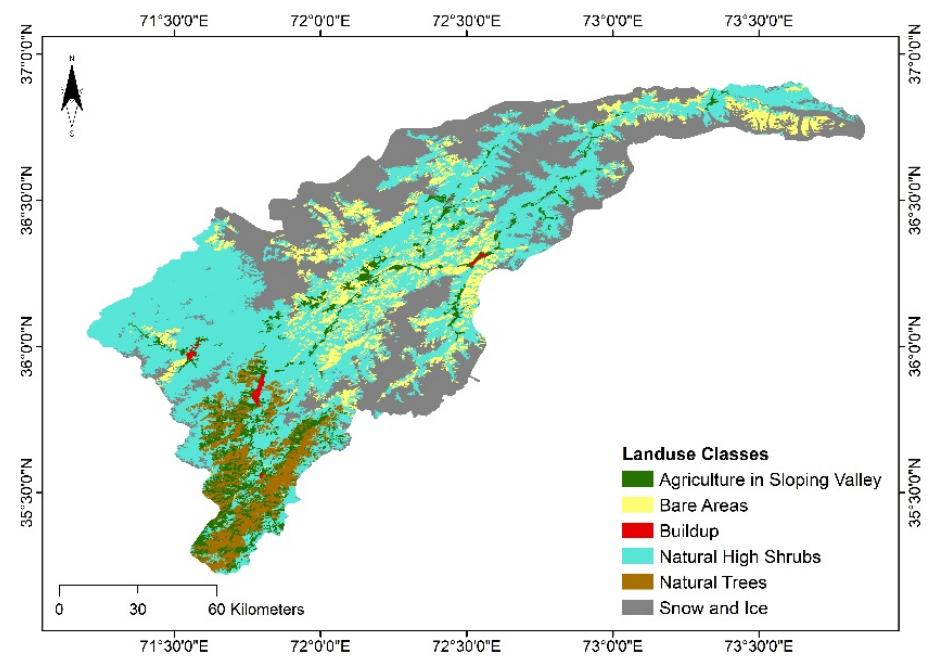
Figure 5. Map showing the land use classes of study area. Table 3. Land use classes and their respective areas.